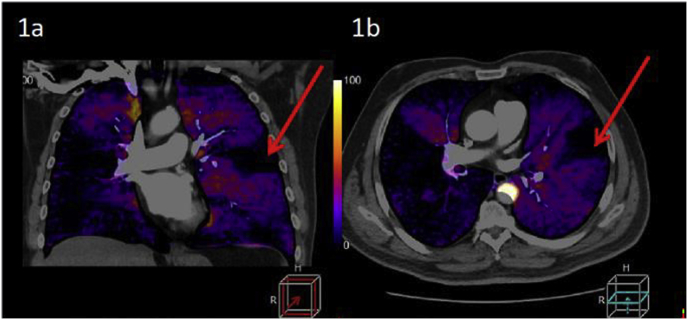
Coronal (1a) and axial (1b) CT-LSIM showing a classical triangular segmental perfusion defect (red arrows). (For interpretation of the references to colour in this figure legend, the reader is referred to the Web version of this article.)